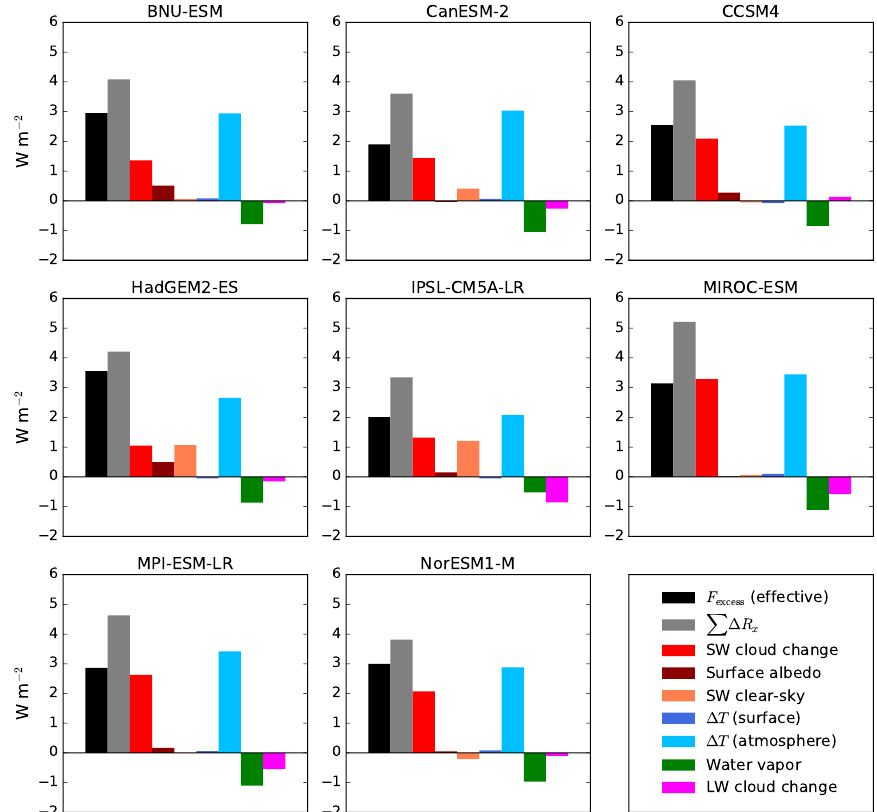
Figure 10. Excess required solar radiative forcing in G1 versus that expected from effective CO 2 forcing (black bar), global mean SW and LW radiative adjustments (colored bars), and sum of all the radiative adjustments (gray bar), in models for which all of these quantities were calculated. For all except F excess , positive values indicate a warming effect (increase in absorbed SW radiation or reduction in OLR). The first three colored bars correspond to the SW radiative adjustments calculated using APRP (multi-model mean maps shown in Fig. 7). The three blue and green bars correspond to the LW radiative adjustments calculated using radiative kernels (multi-model mean maps shown in Fig. 8). The magenta bar corresponds to the change in LW cloud radiative effect, corrected for cloud masking effects using radiative kernels (multi-model mean map shown in Fig.